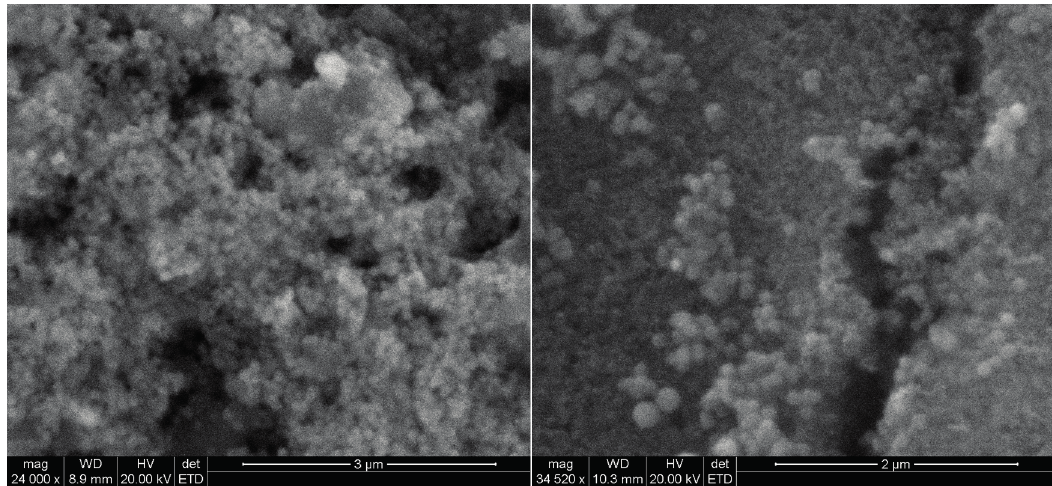
Figure 4. SEM image of the RuNPs modified sensor surface. The nanoparticles appeared to form 3D structures on the electrode surface, thus allowing for immobilization of a high amount of dye. The scale bar is 3 µm ( left ) and 2 µm ( right ).